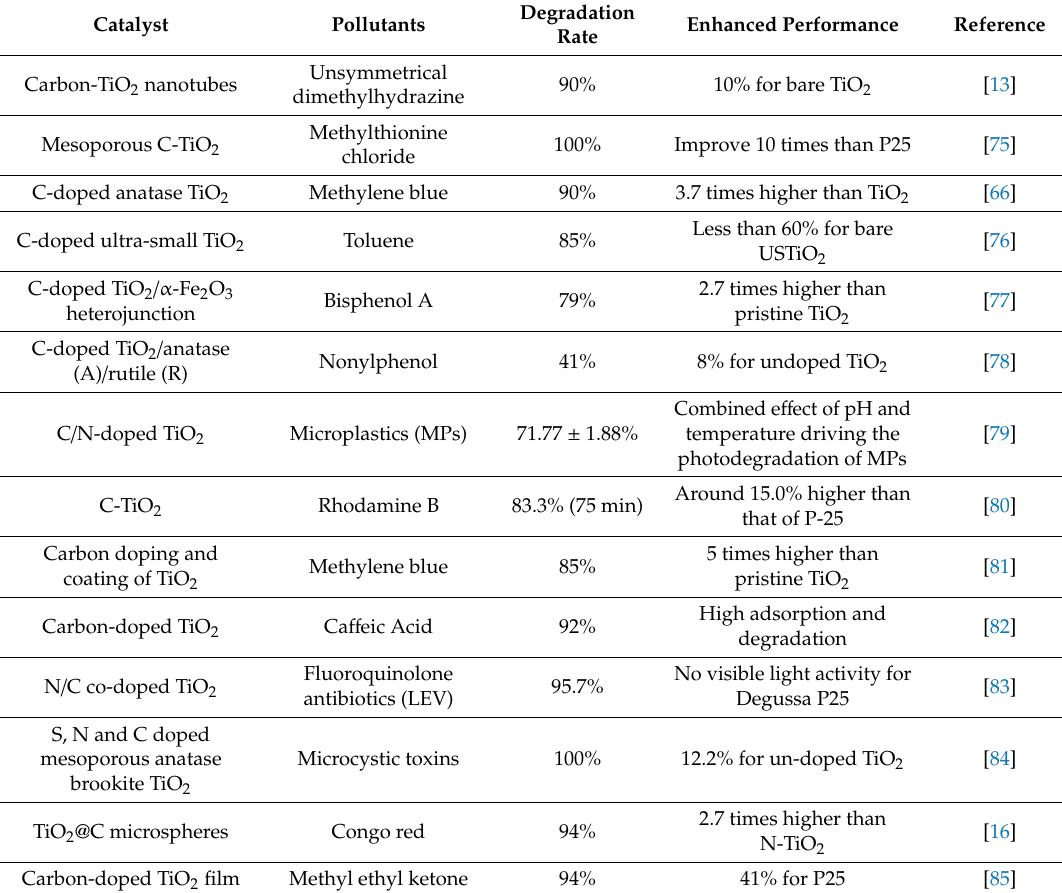
Table 2. The photocatalytic performance of C-doped TiO 2 materials toward the degradation of organic